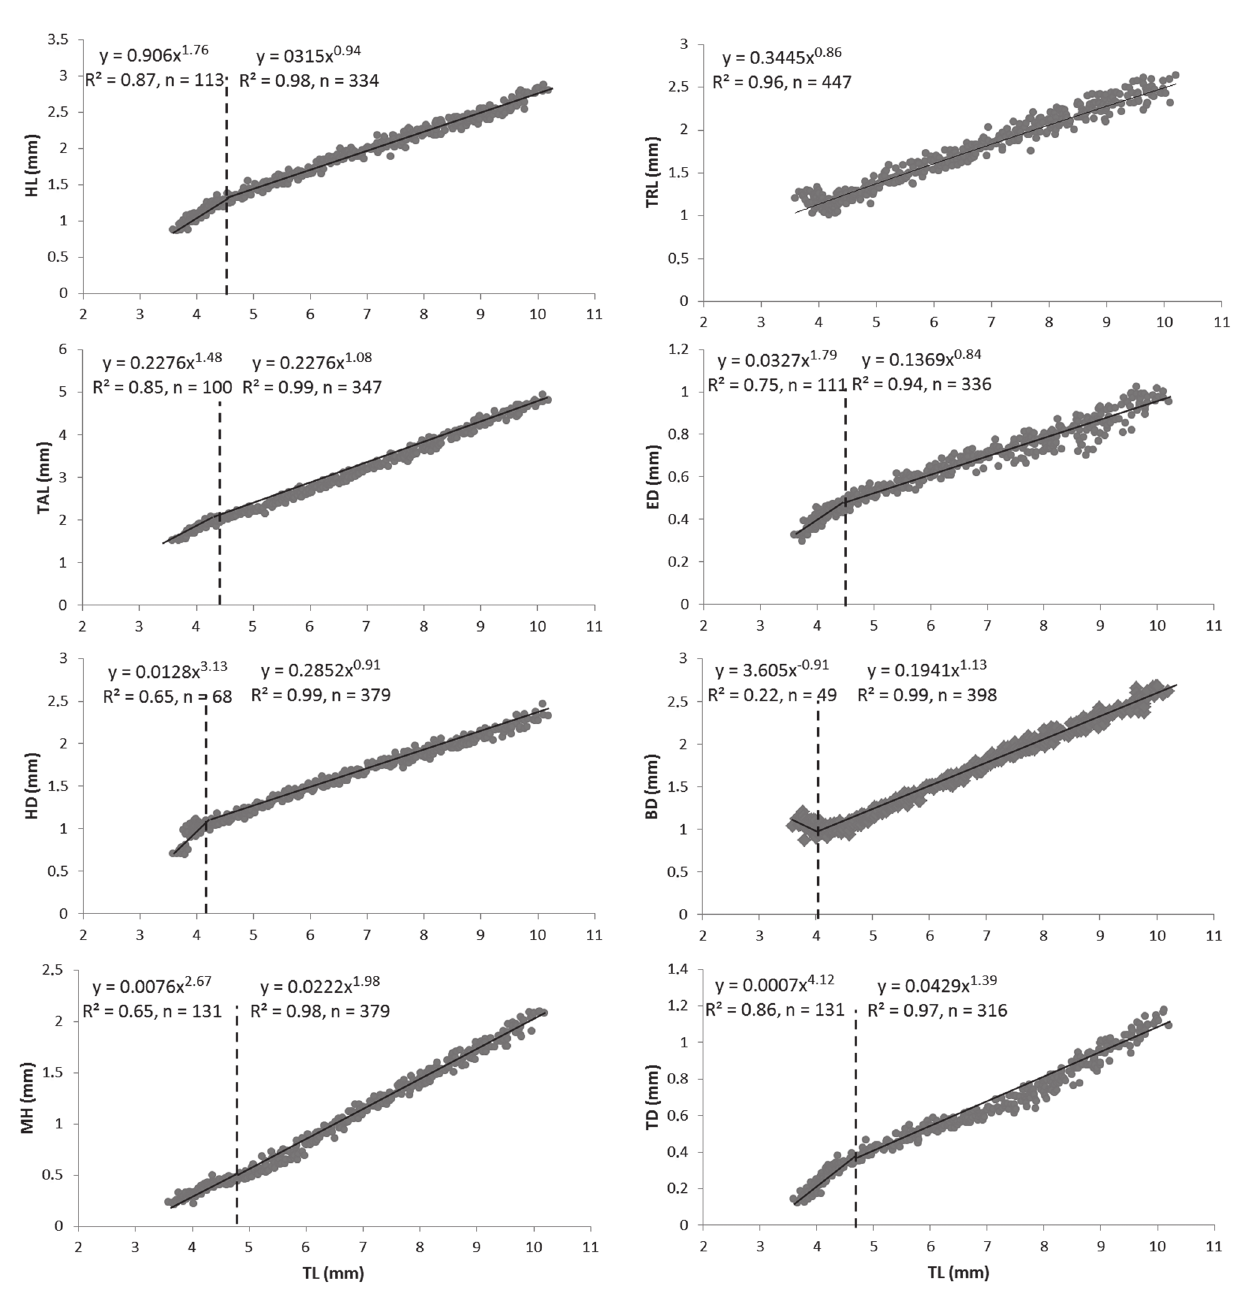
Fig. 5. Allometric growth equations between measured body proportions and total length during Nannacara anomala development. BD, body depth; ED, eye diameter; HD, head depth; HL, head length; MH, musculature height; TAL, tail length; TD, tail depth; TL, total length and TRL, trunk length. The dashed line represents the inflection point of